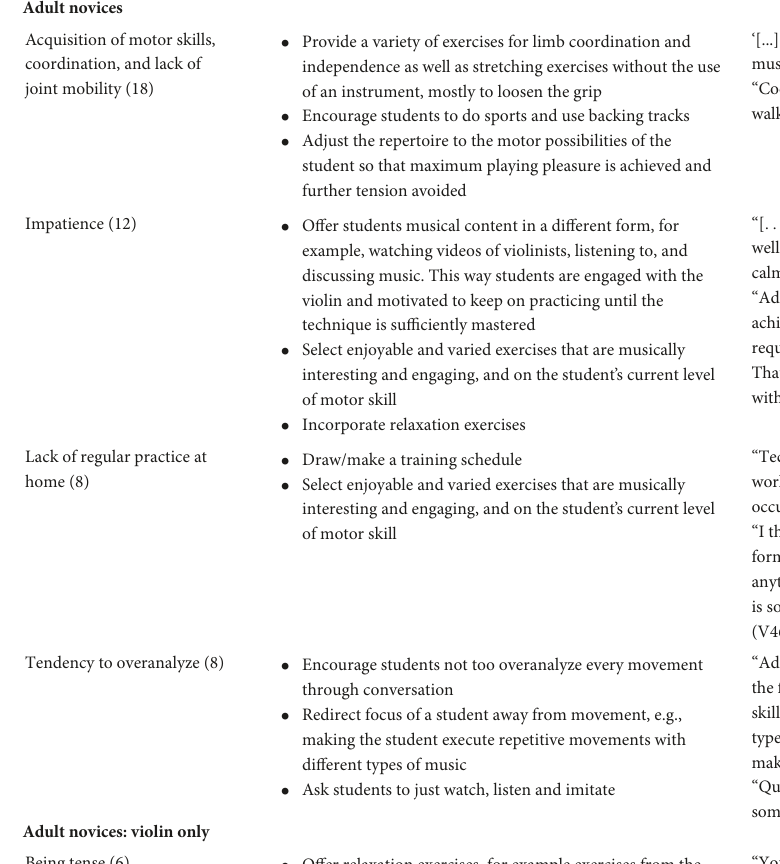
TABLE 2 Teachers’ reported challenges and